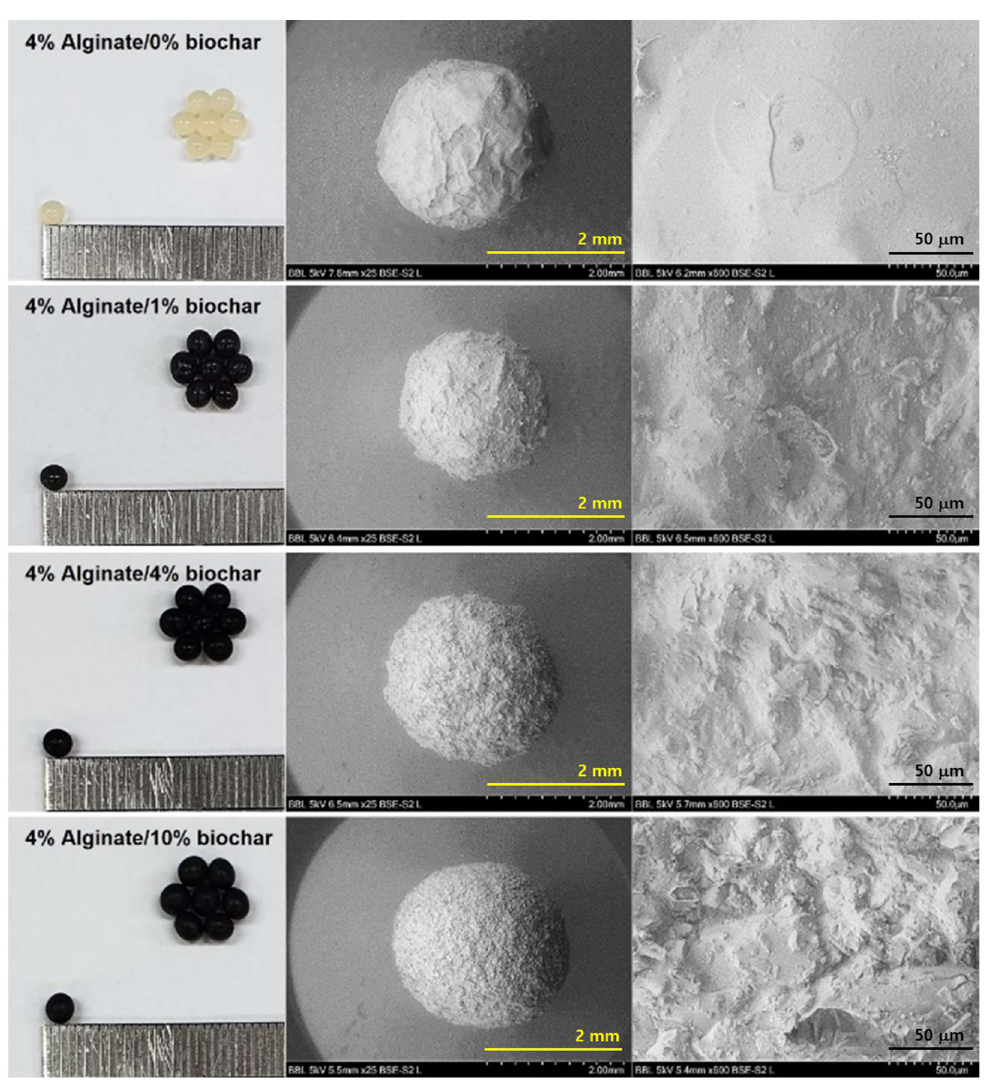
Figure 2. Optical microscopy and SEM images of alginate and alginate/biochar hydrogel